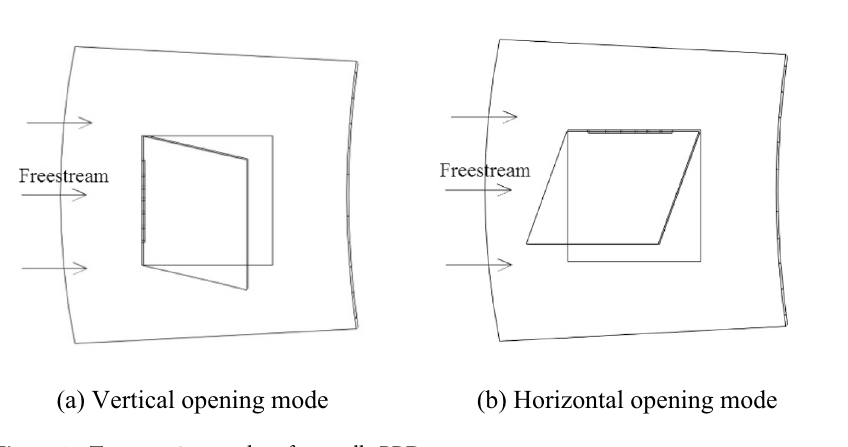
Figure 1. Two opening modes of a nacelle